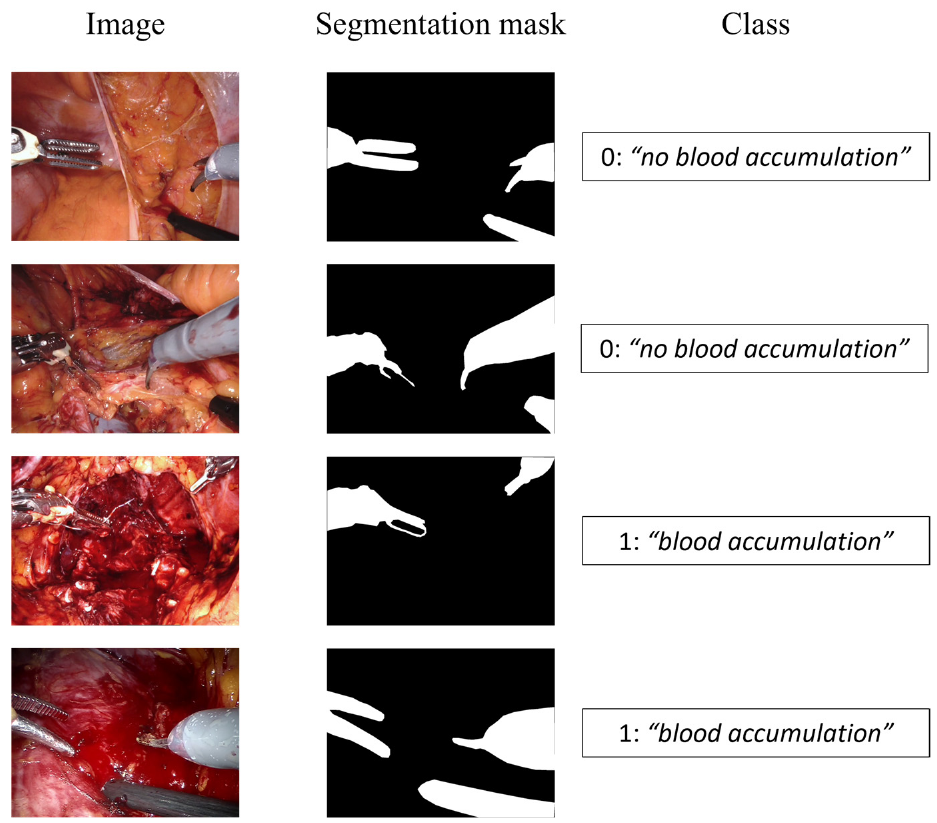
Figure 3. Dataset samples. The first column displays the input image, the second shows the segmen- tation mask for the semantic segmentation branch, and the third represents the class for the event detection branch.